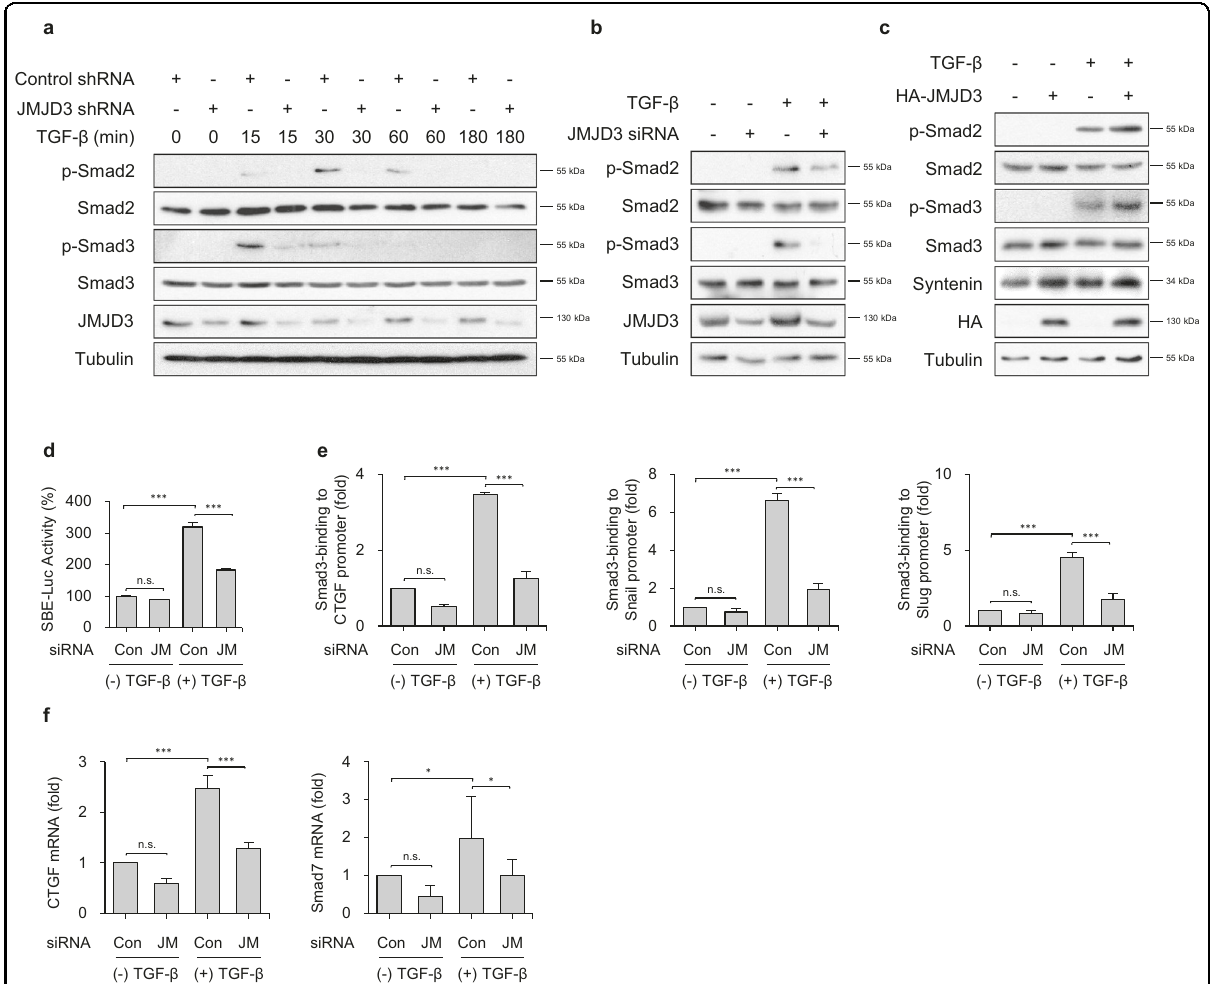
Fig. 3 JMJD3 enhances TGF- β 1-induced Smad2 and Smad3 activation via induction of syntenin. a Phosphorylation of endogenously expressed smad2 and smad3 in BZR cells transfected with control shRNA or JMJD3 shRNA in response to TGF- β 1 (5 ng/ml) for the indicated periods of time. b Expression level of p-smad2 and p-smad3 in A549 cells transfected with JMJD3 siRNA in response to TGF- β 1 (5 ng/ml) for 1 h. c Expression level of p-smad2 and p-smad3 in BEAS-2B cells transfected with HA-tagged JMJD3 expression vector in response to TGF- β 1 (5 ng/ml) for 1 h. d Luciferase activity of SBE-Luc reporter plasmid-expressed BZR cells transfected with control siRNA or JMJD3 siRNA in response to TGF- β 1 (5 ng/ml) for 24 h. Columns, mean of three independent experiments performed in triplicate; bar , S.D.; *** P < 0.001 versus control, n.s.: nonsigni fi cant. e Chromatin immunoprecipitation (ChIP) assay to analyze smad3-binding to target promoters such as CTGF (left panel), snail (middle panel), and slug (right panel) in BZR cells transfected with control siRNA or JMJD3 siRNA in response to TGF- β 1 (5 ng/ml) for 1 h. Columns, mean of two independent experiments performed in triplicate; bar , S.D.; *** P < 0.001 versus control, n.s.: nonsigni fi cant. f Real-time RT-PCR of CTGF (left panel) and smad7 (right panel) expression levels in A549 cells transfected with control siRNA or JMJD3 siRNA in response to TGF- β 1 (5 ng/ml) for 12 h. Columns, mean of three independent experiments performed in triplicate; bar , S.D.; * P < 0.05, *** P < 0.001 versus control, n.s.: nonsigni fi